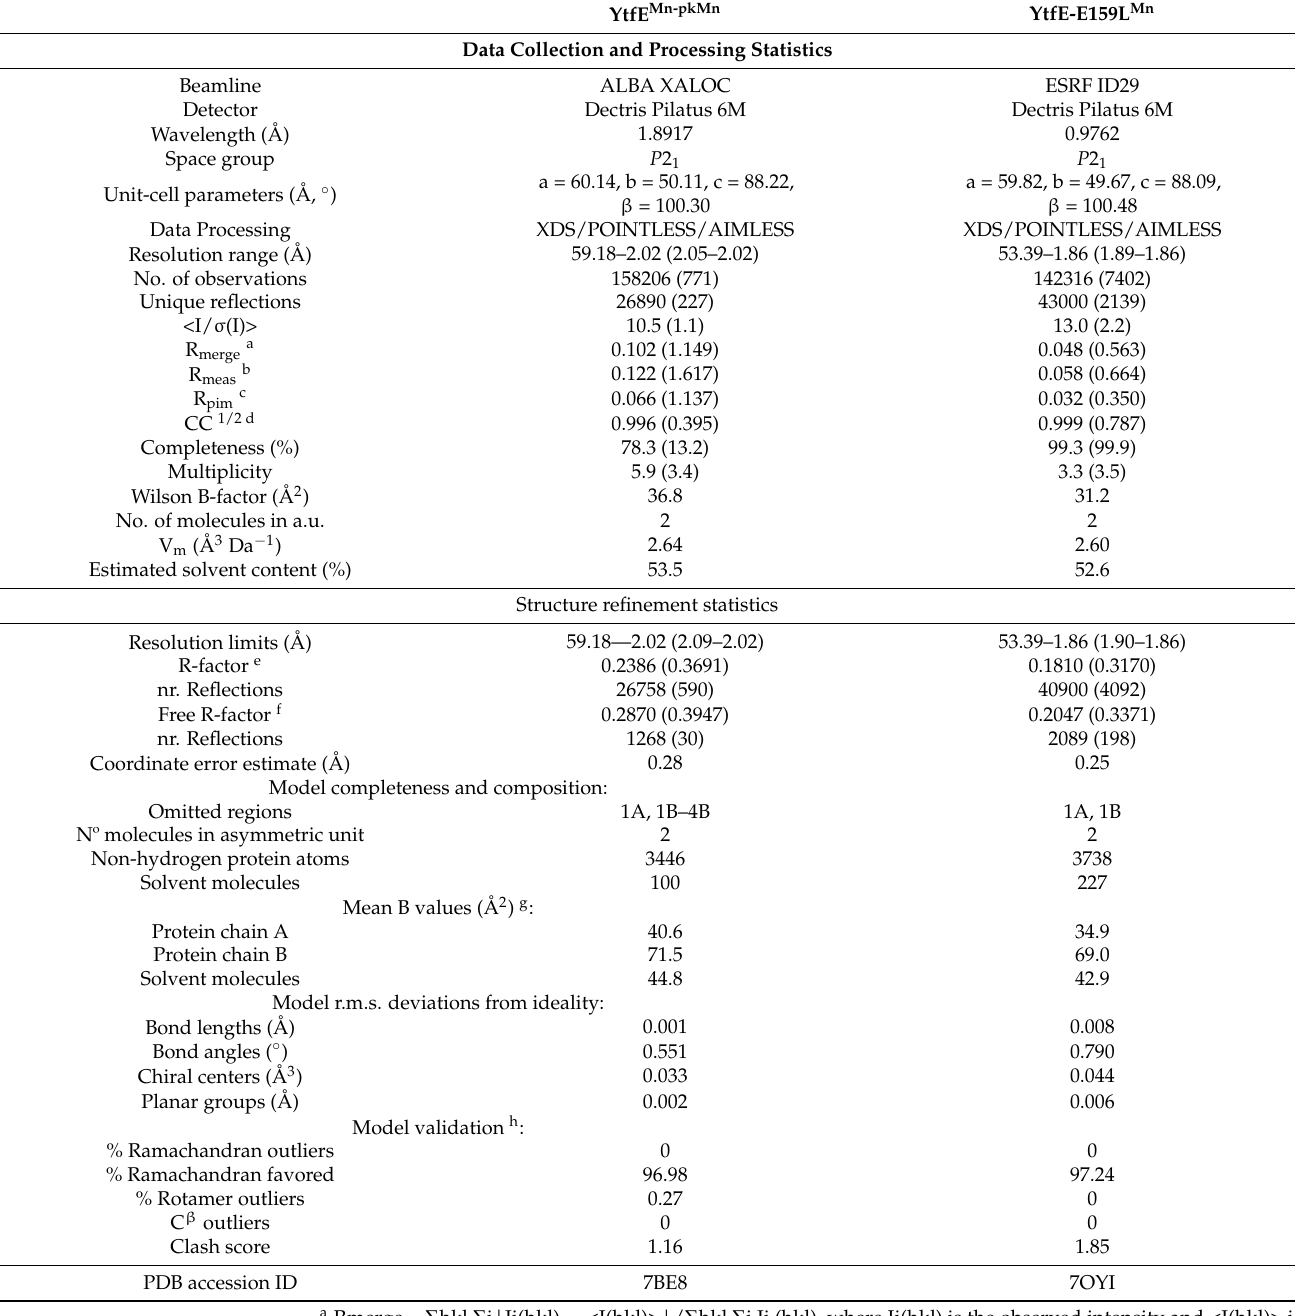
Table 3. Data collection, processing, and refinement statistics for the crystal structures of E. coli YtfE wild type and E159L proteins with manganese in the metal